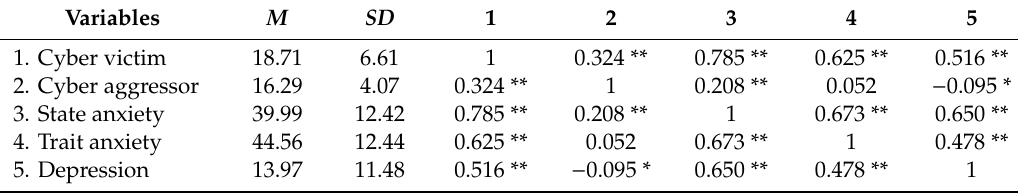
Table 2. Means, standard deviations, and correlations between the main variables ( N = 501).